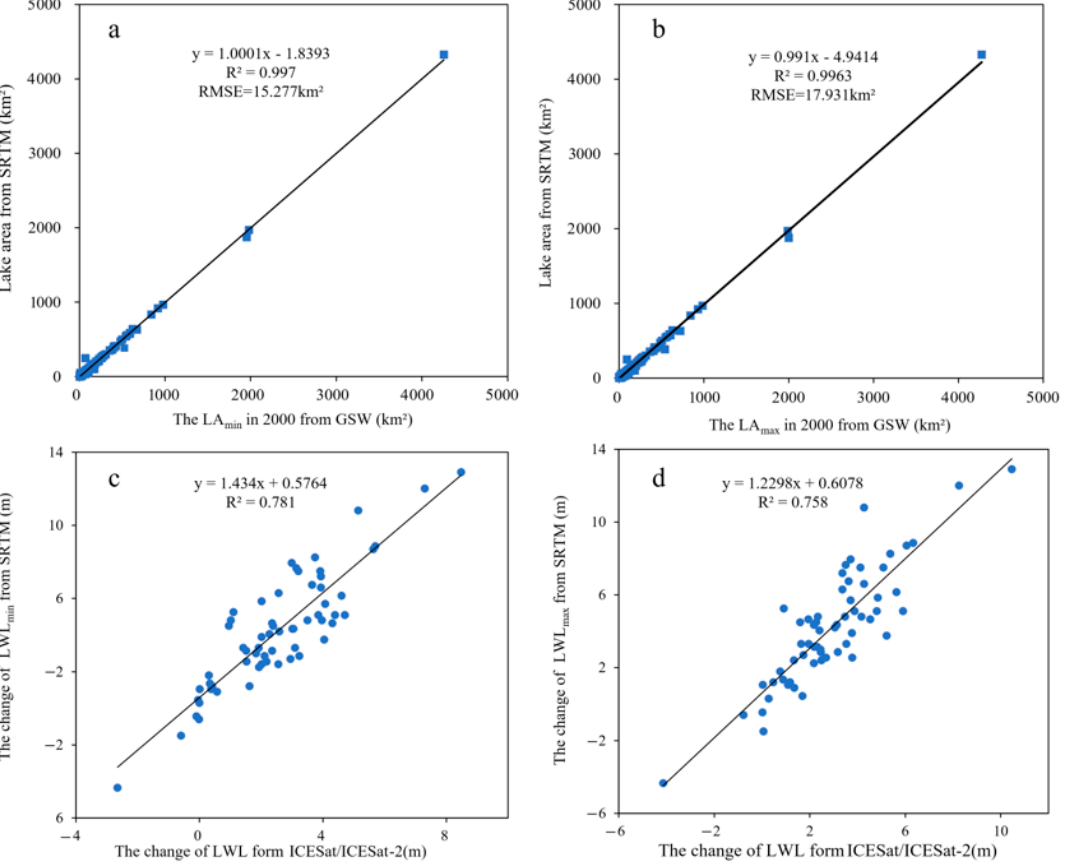
Figure 2. Accuracy verification of lake water level changes on the TP: ( a ) the LA min in 2000 from GSW compared with LA from SRTM DEM; ( b ) the LA max in 2000 from GSW compared with LA from SRTM DEM; ( c ) the LWL min compared with LWL from the ICESat/ICESat-2; ( d ) the LWL max compared with LWL from the